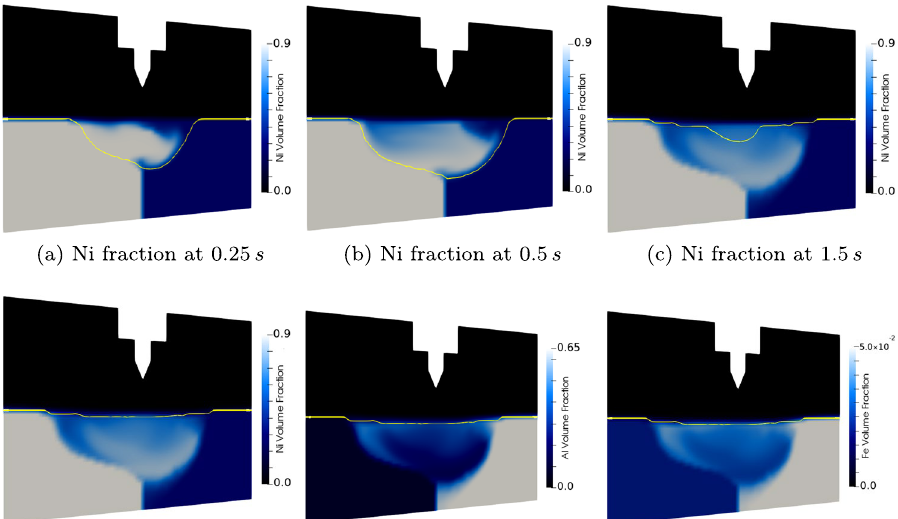
Figure 7. Temporal evolution of the phase fractions at a cross section through the mid plane of the domain, normal to the initial boundary between alloys 1 and 2. The boundary between the solid and fluid regions is shown in yellow. As more of the substrate melts, and the convective flow is established in the metal, the two alloys begin to mix together, prior to solidification. Note that the difference in melting temperatures is evident from the melt-pool